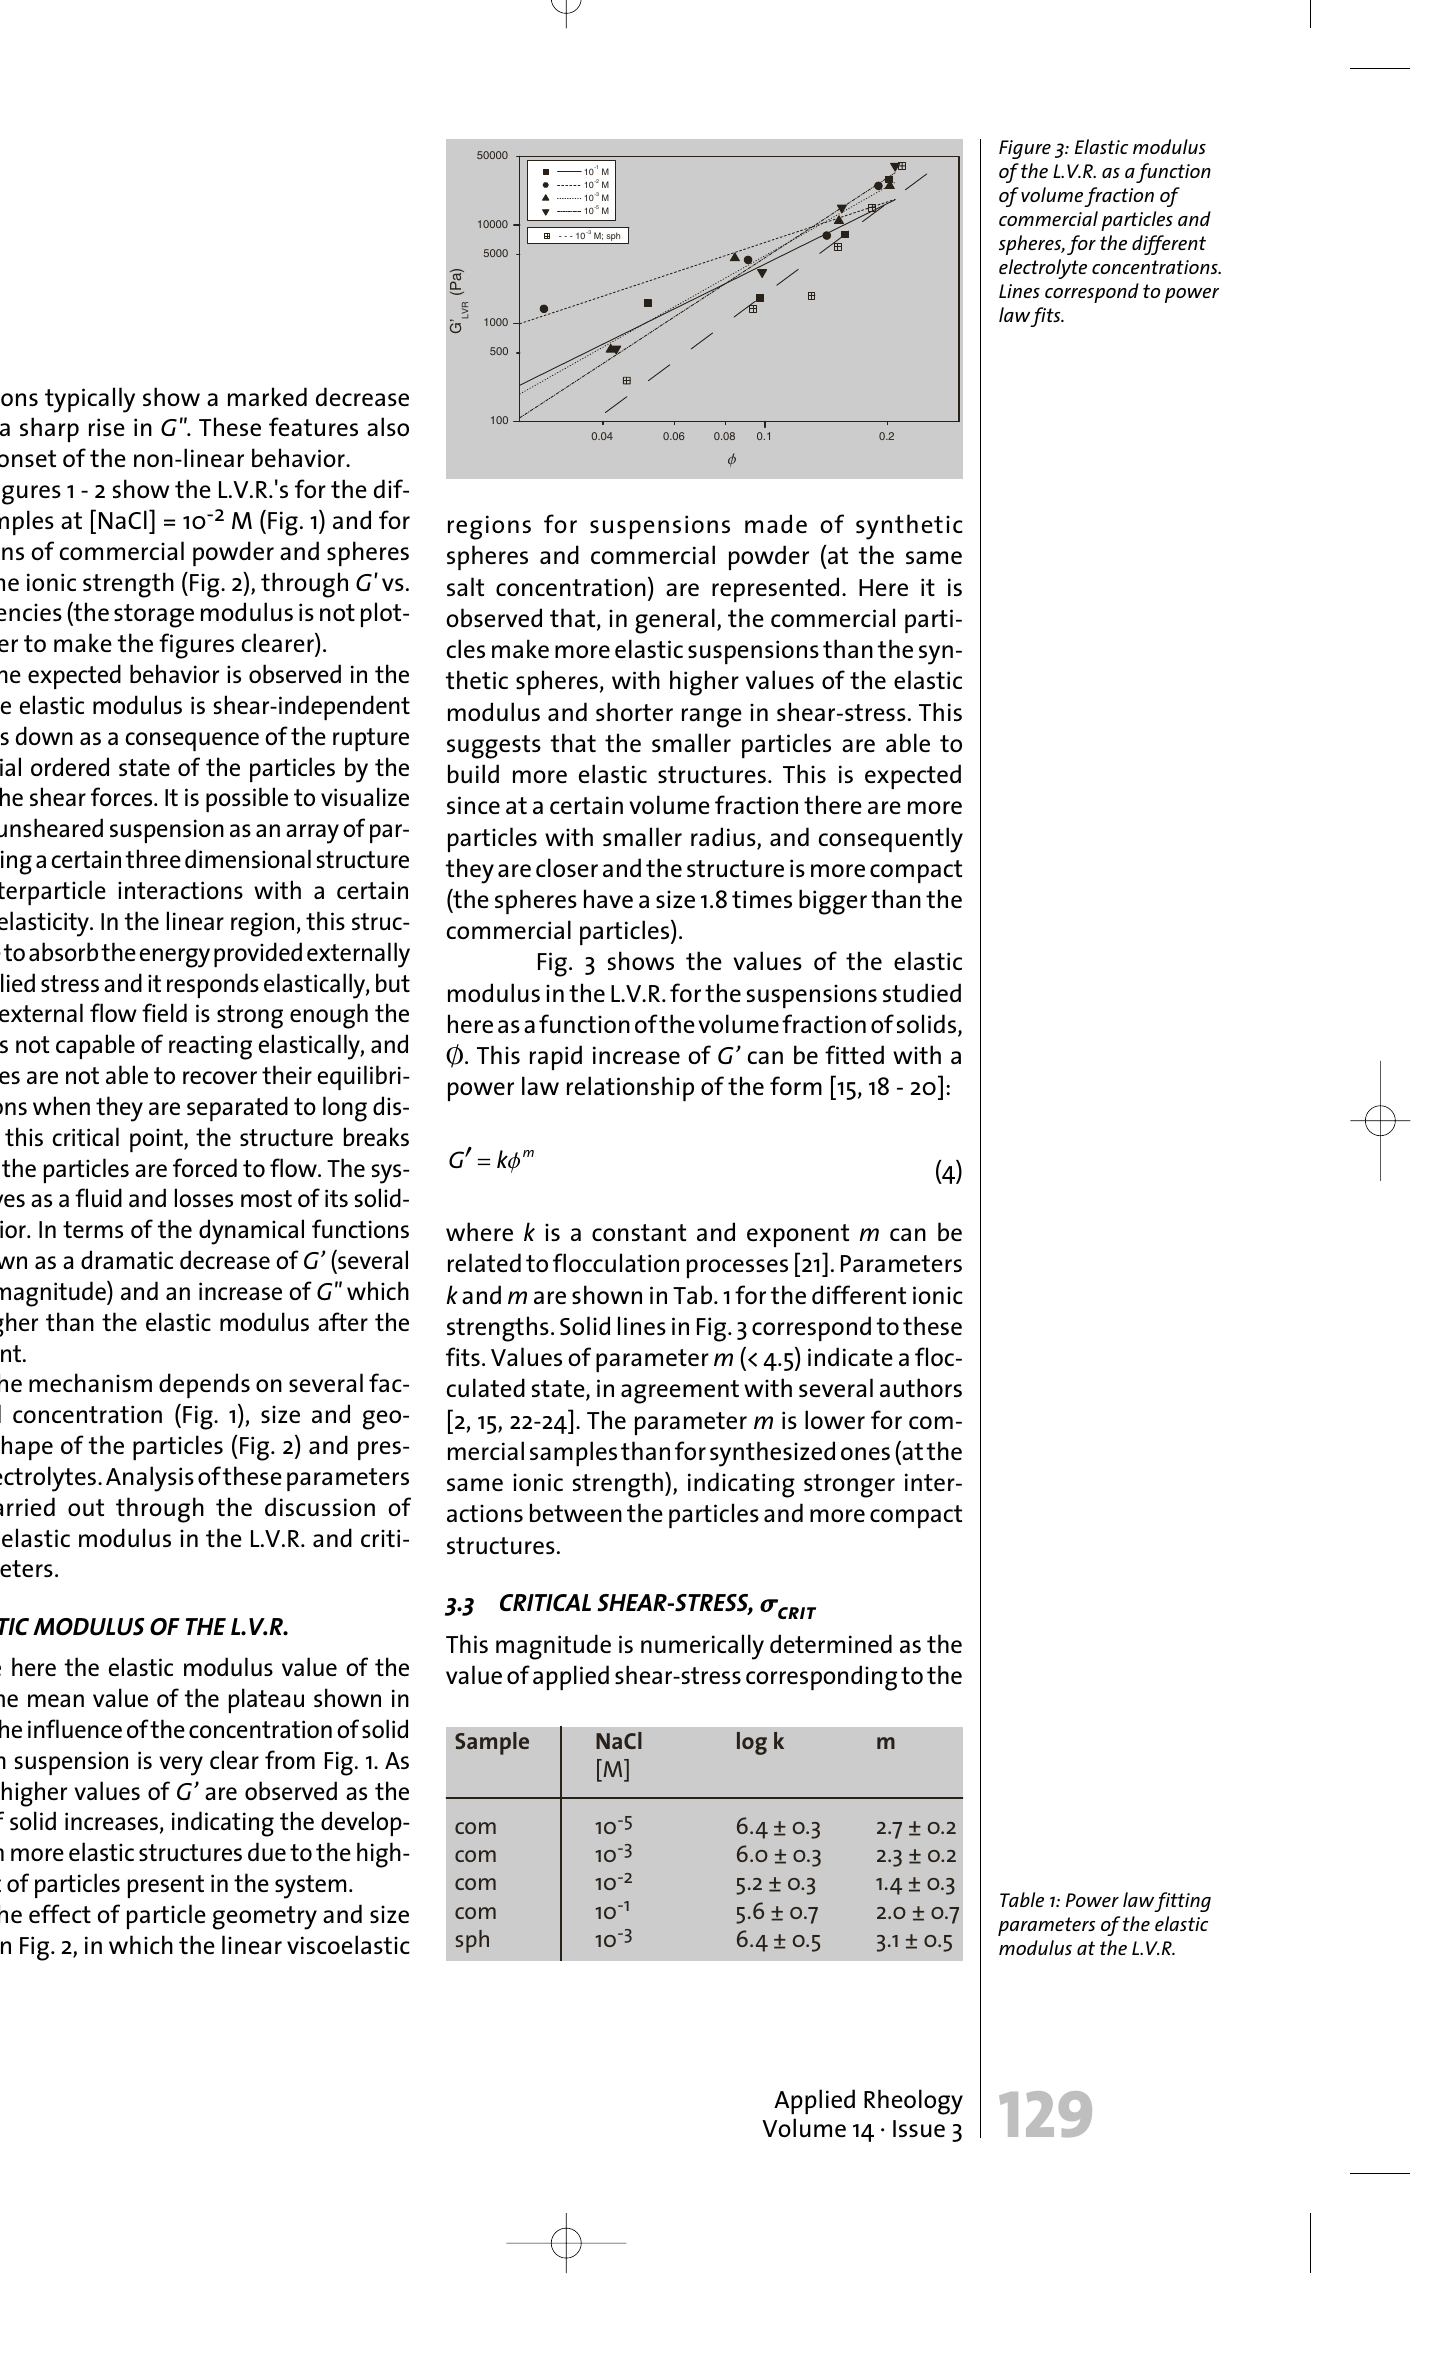
Table 1: Power law fitting parameters of the elastic modulus at the